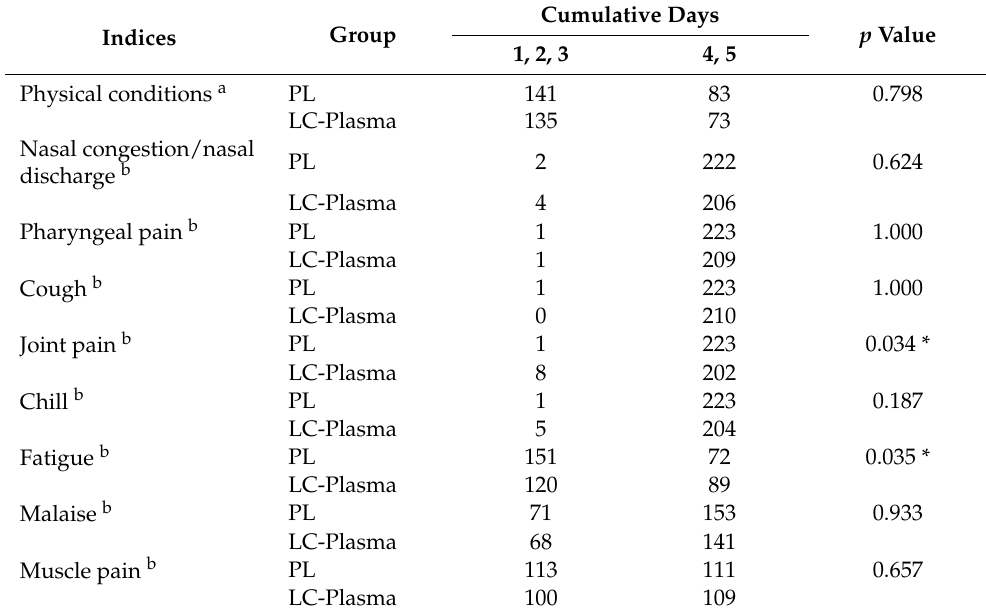
Table 3. Cumulative days of physical conditions and fatigue symptoms during the continuous exercise